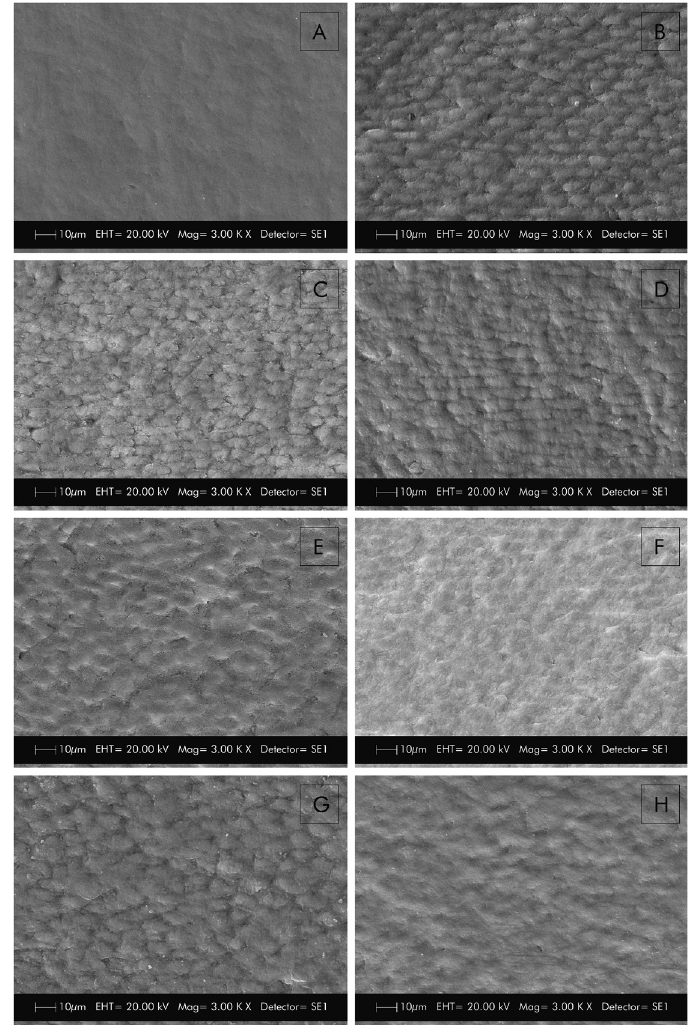
Figure 4- Representative images of scanning electron microscopy analysis. A- Sound surface; B- Initial erosion surface; C- Surface irradiated with the Er:YAG laser; D- Surface non-irradiated; E- Surface irradiated with the Er:YAG laser and eroded during in situ phase; F- Surface non-irradiated and eroded during in situ phase; G- Surface irradiated with the Er:YAG laser and eroded+abraded during in situ phase; H- Surface non-irradiated and eroded+abraded during in situ